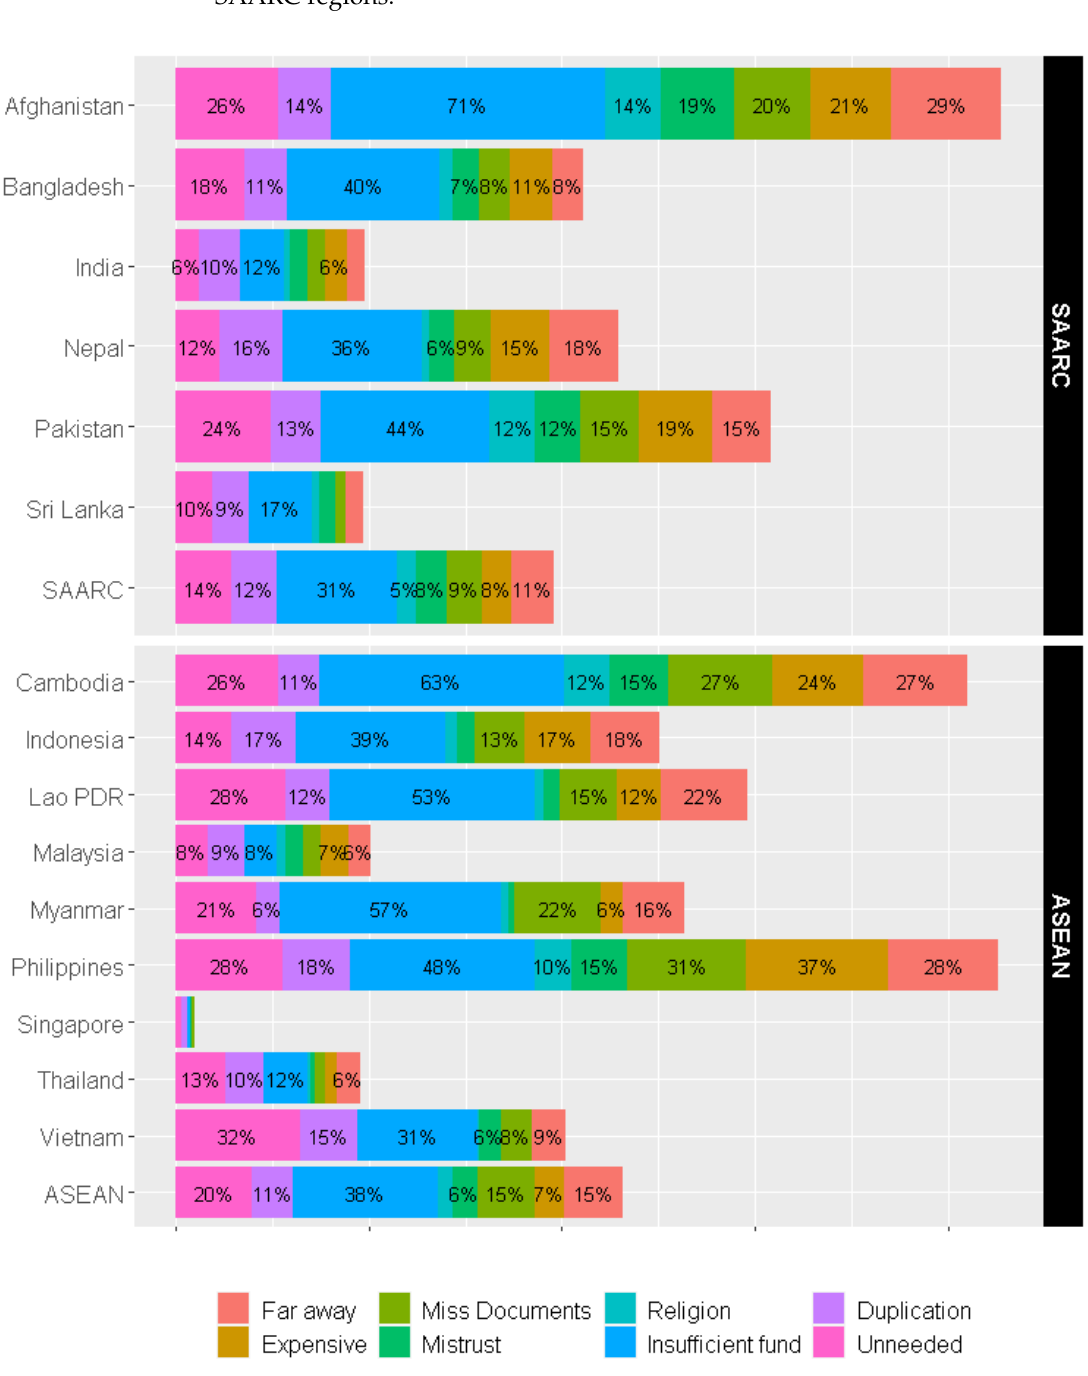
Figure 4. Cumulative percentage of participants indicating barriers to having a bank account .